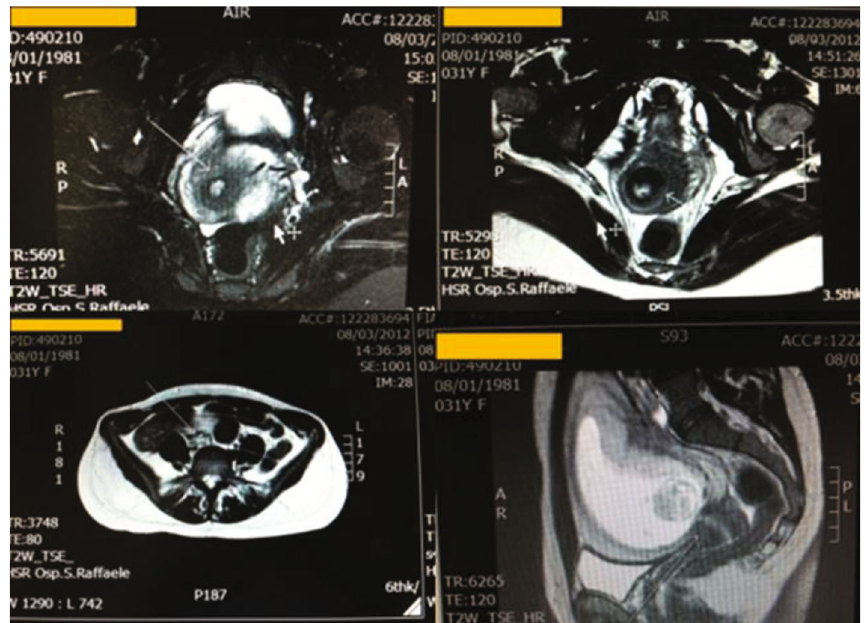
Figure 2: MRI mild-signal hyperintensity in the posterior-left and front cervical side (arrows); no aspects of in fi ltration of the parametrium.